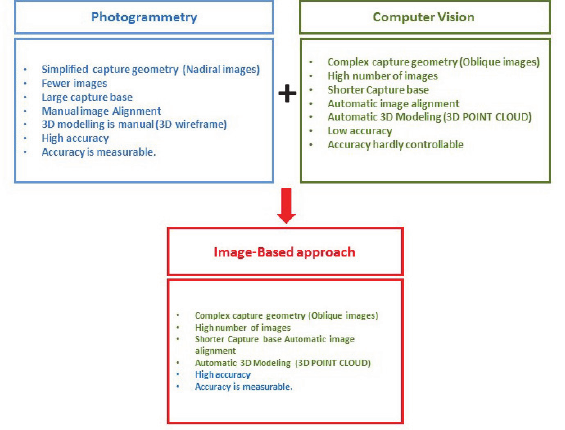
Figure 10: Photogrammetry joints Computer Vision creating Image Based modelling Approach. Advantages and disadvantages are listed. Image based approach inherits the advantages of the two methodology.